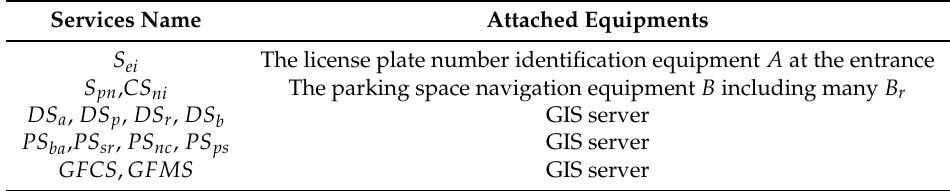
Table 6. Attached equipments of the